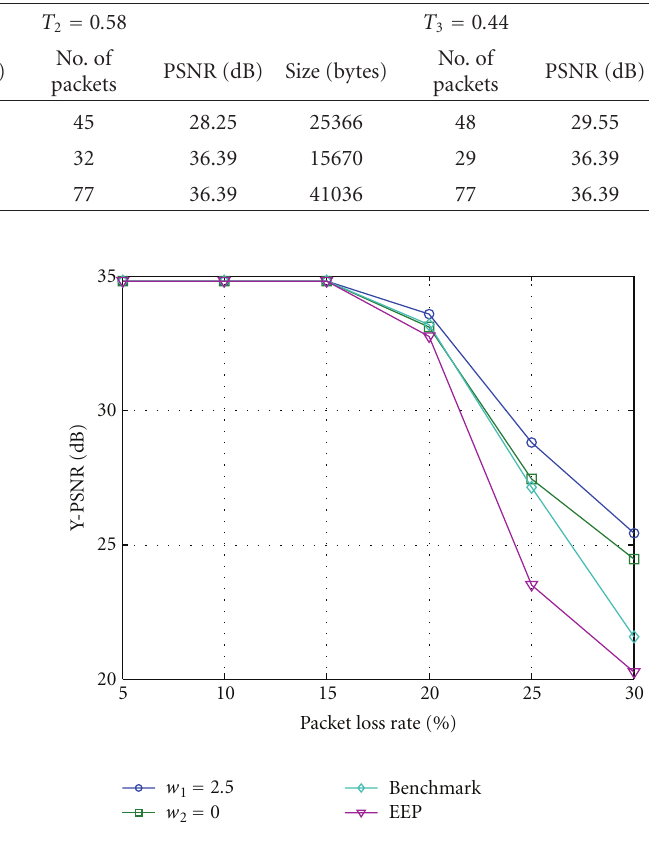
w for the Paris